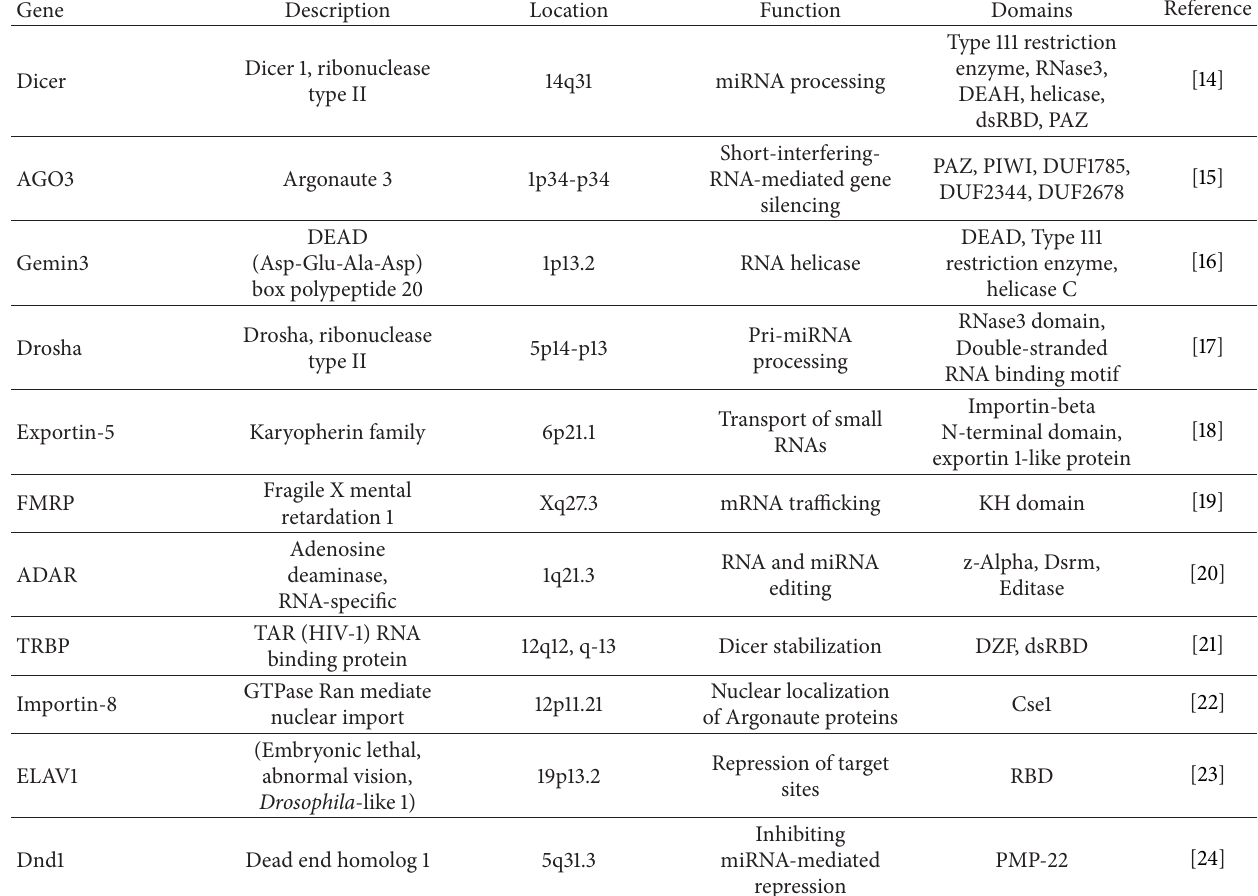
Table 2: Proteins involved in miRNA